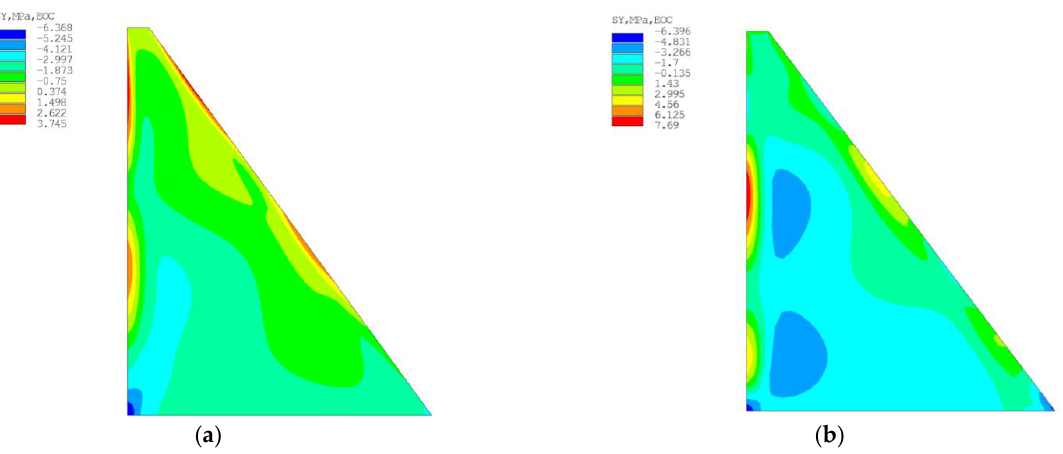
Figure 14 . Results of calculation of tensile stresses 𝜎 𝑦 in the concrete mass at the time of completion of construction: ( a ) The most favorable calculation case; ( b ) The least favorable calculation case.